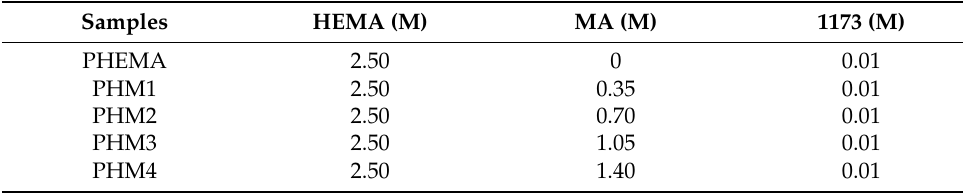
Table 1. The composition of the hydrogels with different MA